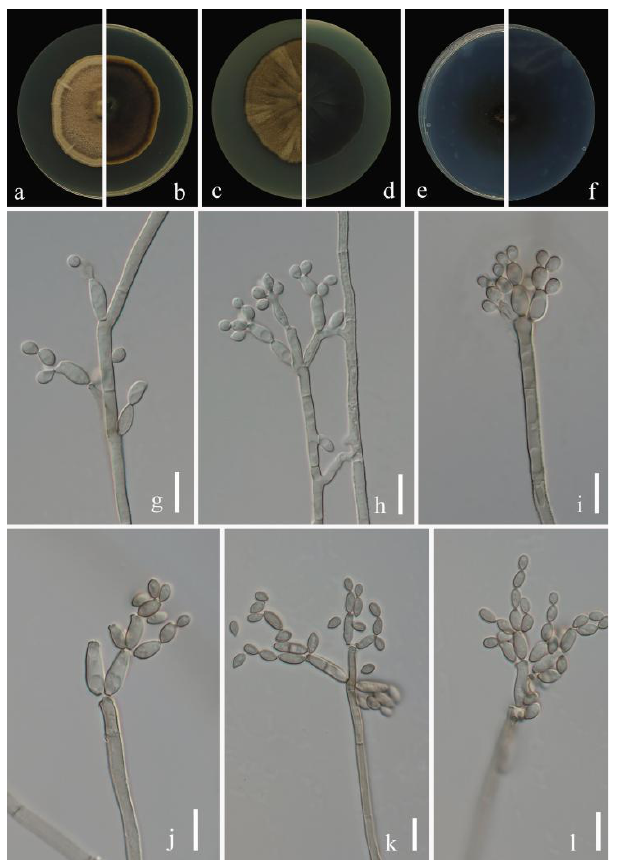
Figure 2. Cladosporium pruni-salicina (HGUP 21206, holotype). ( a , b ) Culture on PDA from above and reverse. ( c , d ) Culture on MEA from above and reverse. ( e , f ) Culture on SNA from above and reverse.